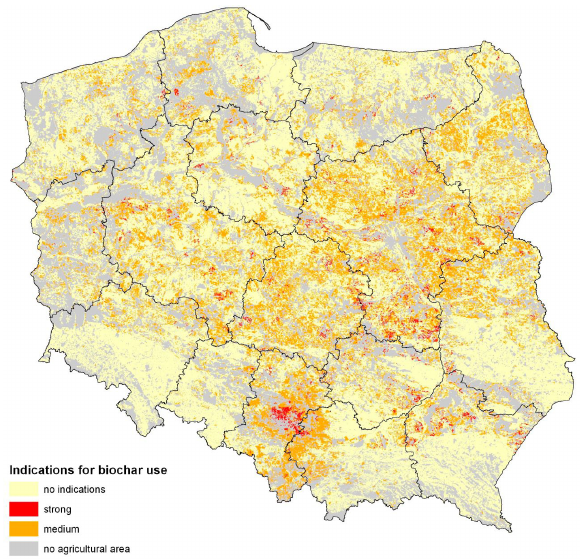
Fig. 3. Preliminary prioritization of areas that could benefit from biochar use. In orange are the areas with medium potential for biochar use: elevated cadmium OR (SOM <= 2 AND pH <= 5.5 AND (texture = sand OR loamy sand)), which equals 21.8% of the agricultural area. Red colour indicates strong potential for biochar application: soils contaminated with cadmium OR (SOM <= 1 AND pH <= 4.5 AND texture = sand), which equals to 1.5% of the